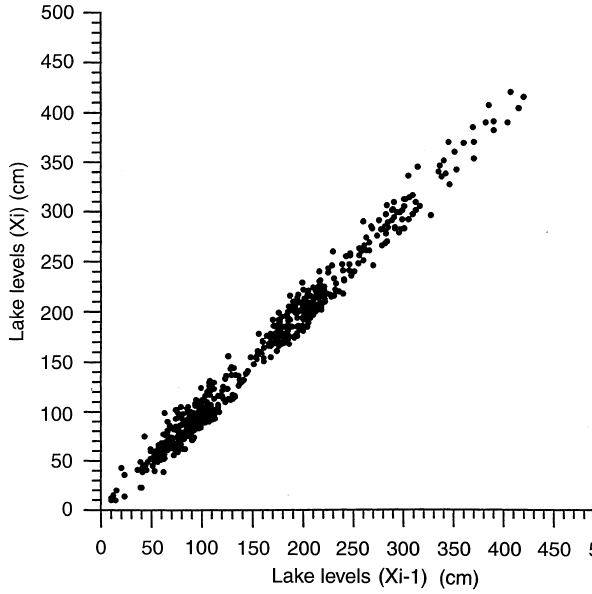
Fig. 8. Synthetic lag-one water